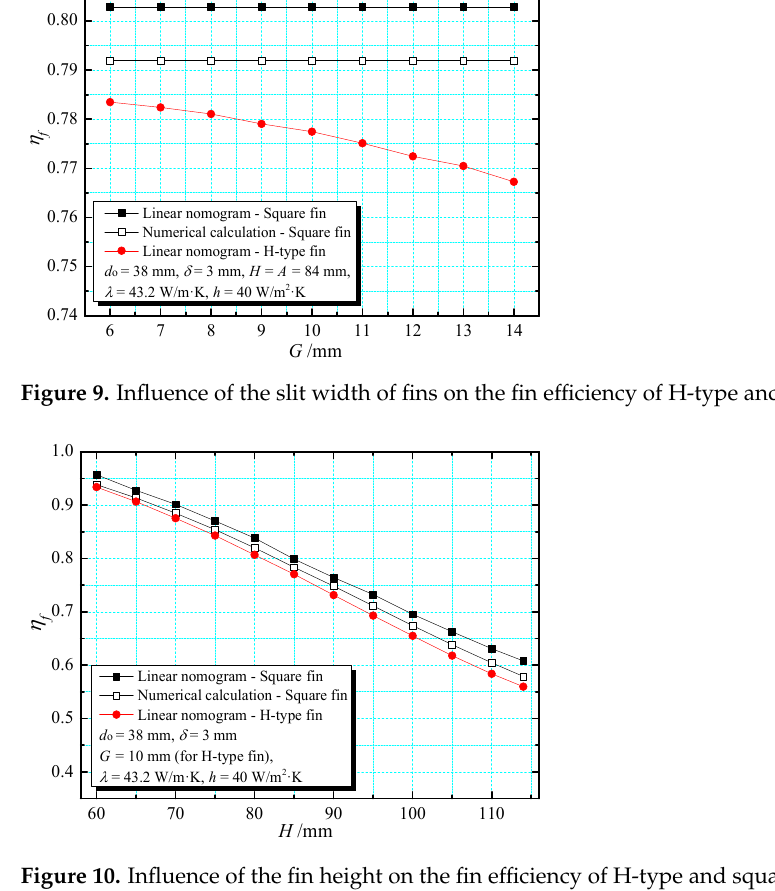
Figure 9. Influence of the slit width of fins on the fin efficiency of H-type and square fins.